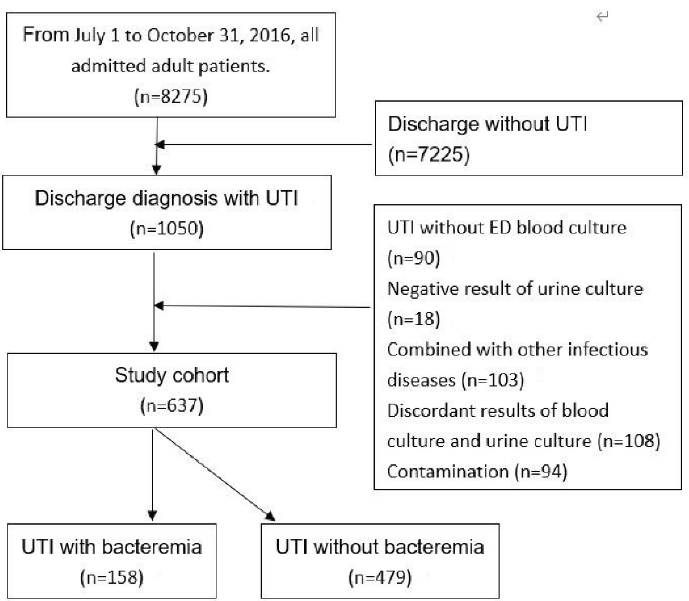
Figure 1. Flow of the patient selection process.